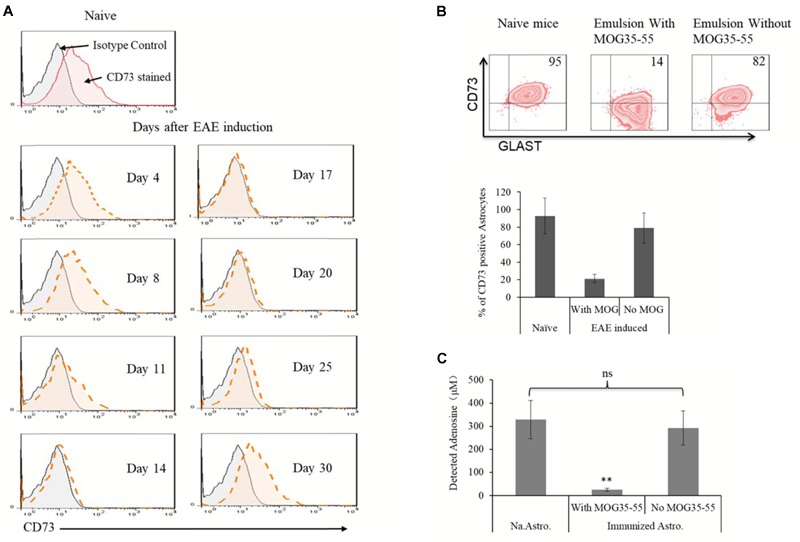
Gradual downregulation of CD73 in astrocytes following EAE induction. EAE-induced B6 mice were euthanized on different days after immunization. A single cell suspension of brain tissues was prepared, and CD73 levels in GLAST-positive cells were evaluated by flow cytometry. B6 mice were immunized with or without MOG35-55 in the emulsion, and CD73 levels in astrocytes were evaluated by flow cytometry. (A) CD73 density in GLAST+ cells. (B) A representative FACS result (upper panel) and the mean percentage of CD73-positive cells (lower panel, n = 6). (C) CD73 enzymatic activity, as represented by adenosine generation (n = 6). ∗∗Statistically significant difference (p < 0.01). ns: no significance.